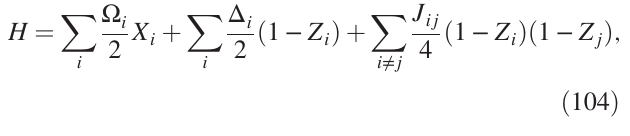
FIG. 7. (a) In the proposed analog Rydberg teleportation protocol, qubits are encoded in a ground state j g i and a Rydberg state j r i . Nearest-neighbor interactions (dark blue) can be time reversed, but next-nearest neighbor interactions (light blue) cannot. (b) Numerical results comparing the average state teleportation fidelity for single-qubit teleportation with perfectly reversed time evolution (solid lines) with the proposed, imperfect time reversal (dashed lines). In particular, we implement the one-sided protocol using N ¼ 20 total spins; K ¼ N − 1 measured spins (i.e., all except the spin encoding j ψ i ), whose single-qubit rotations are generated by evolution under the analog Rydberg Hamiltonian [Eq. (104)] with parameters Ω (c) Implementation of U or U † in the digital protocol, consisting of alternating layers of controlled-phase gates (horizontal black lines) between nearest-neighbor atoms and single-qubit rotations (red boxes). Here, qubits are encoded in two hyperfine ground states. Insets show possible pulse sequences to implement the controlled-phase gate and the single-qubit rotations [102]. The full TW protocol is obtained by inserting this gate sequence (and its Hermitian conjugate) in place of U and U † in Fig.